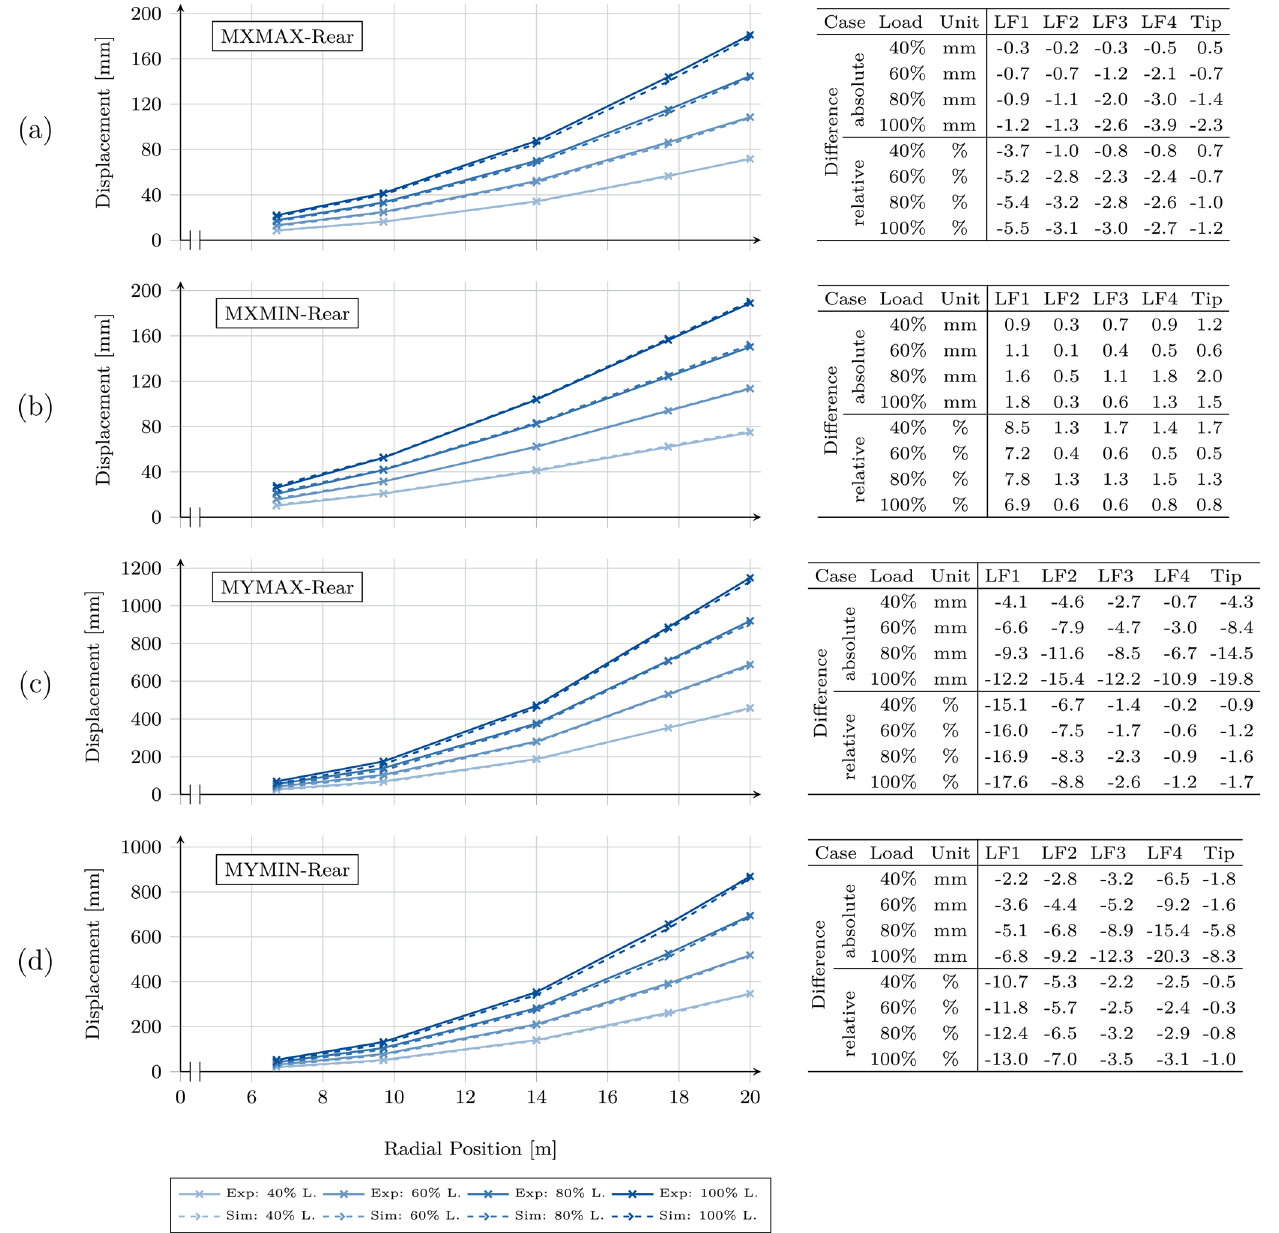
Figure A1. Bending lines extracted from the rear draw-wire sensor for the (a) MXMAX, (b) MXMIN, (c) MYMAX, and (d) MYMIN experiment and simulation. Results are shown for 40%, 60%, 80%, and 100% of the target load. The table on the right shows the differences between the simulation and the